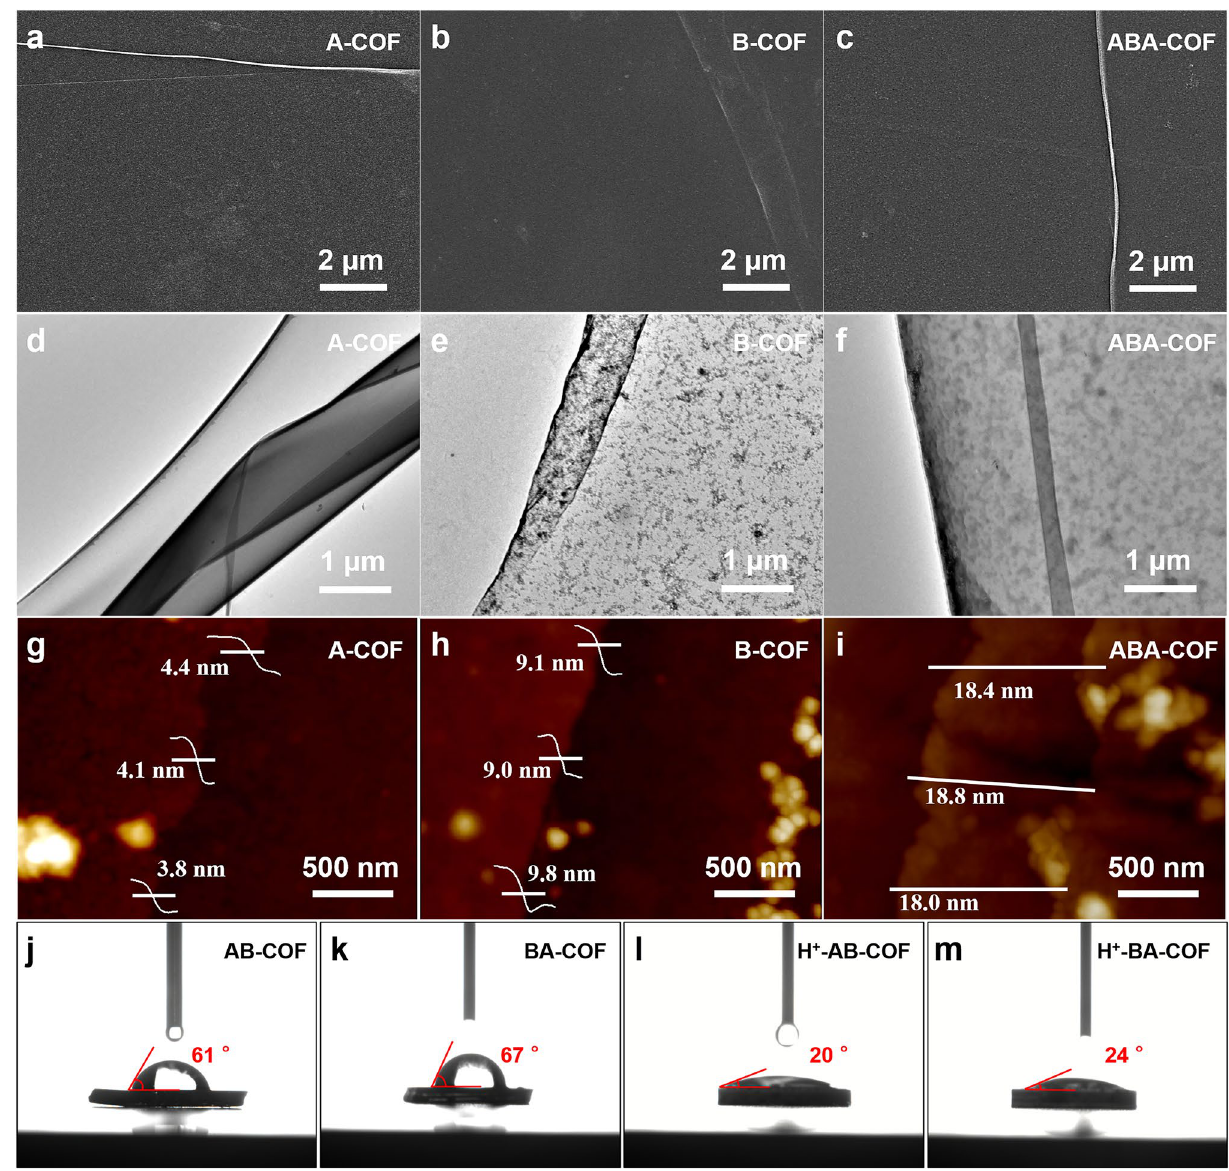
Fig. 1 a–c SEM, d–f TEM and g–i AFM images of A-COF film, B-COF film, and ABA-COF superlattice. The contact angle of j AB-COF, k BA-COF, l H + -AB-COF and m H +